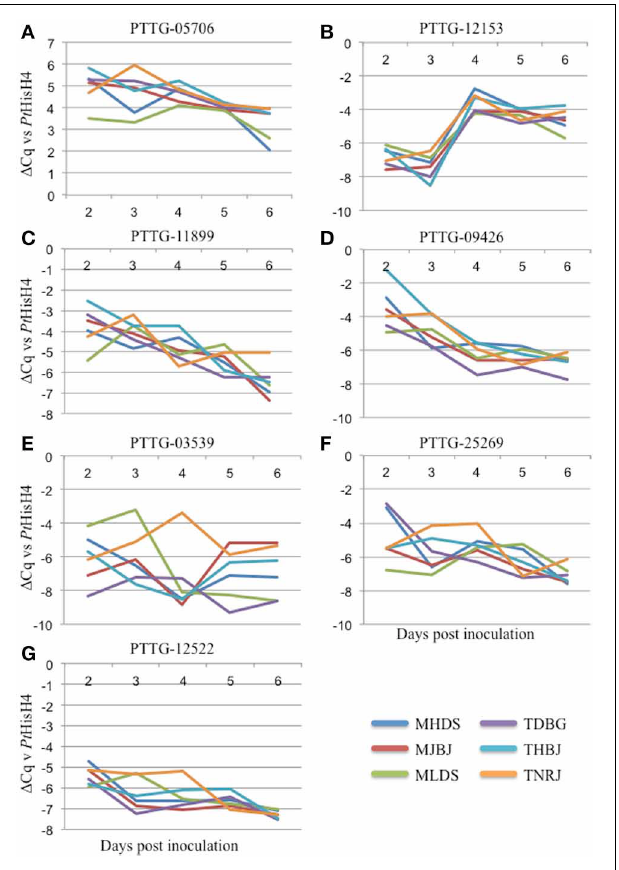
FIGURE 3 | Gene expression profiles for seven avirulence candidates from P. triticina . Plant samples were taken at 24h intervals post inoculation (X axis). Real-time PCR was used to quantify expression of each gene. P. triticina Histone H4 (PtHisH4) was used as the internal control for normalization. (cid:2) Cq vs. PtHisH4 was used to plot expression (Y